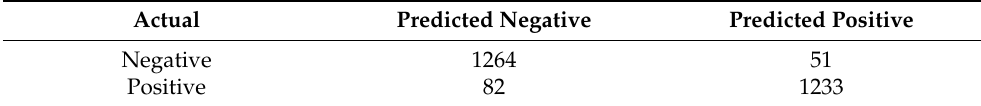
Table 19. Confusion matrix for NB model